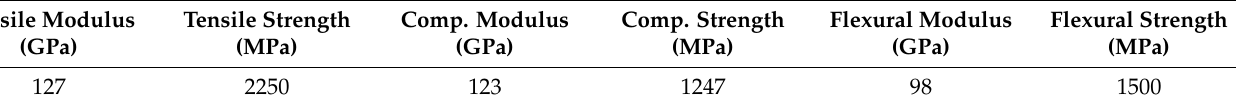
Table 1. Mechanical properties of the [0 5 /90 2 /0 4 ] CFRP tube.